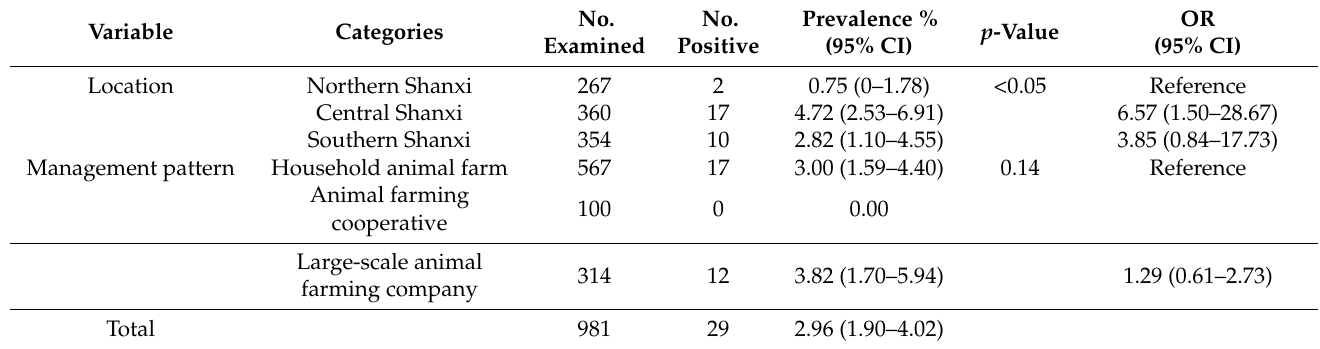
Table 4. Analysis of the related variables of C. abortus infection in cattle in Shanxi